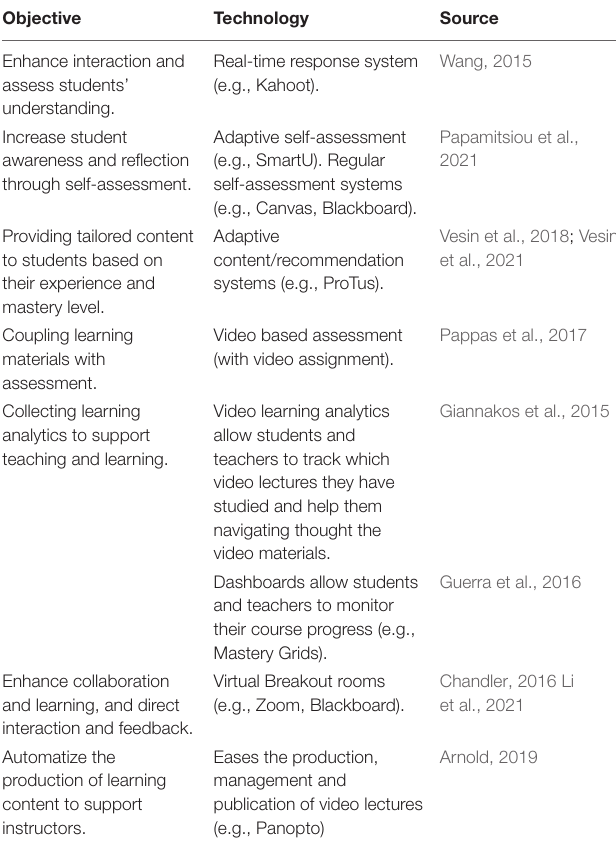
TABLE 1 | Objectives, technology, and indicative case studies from the